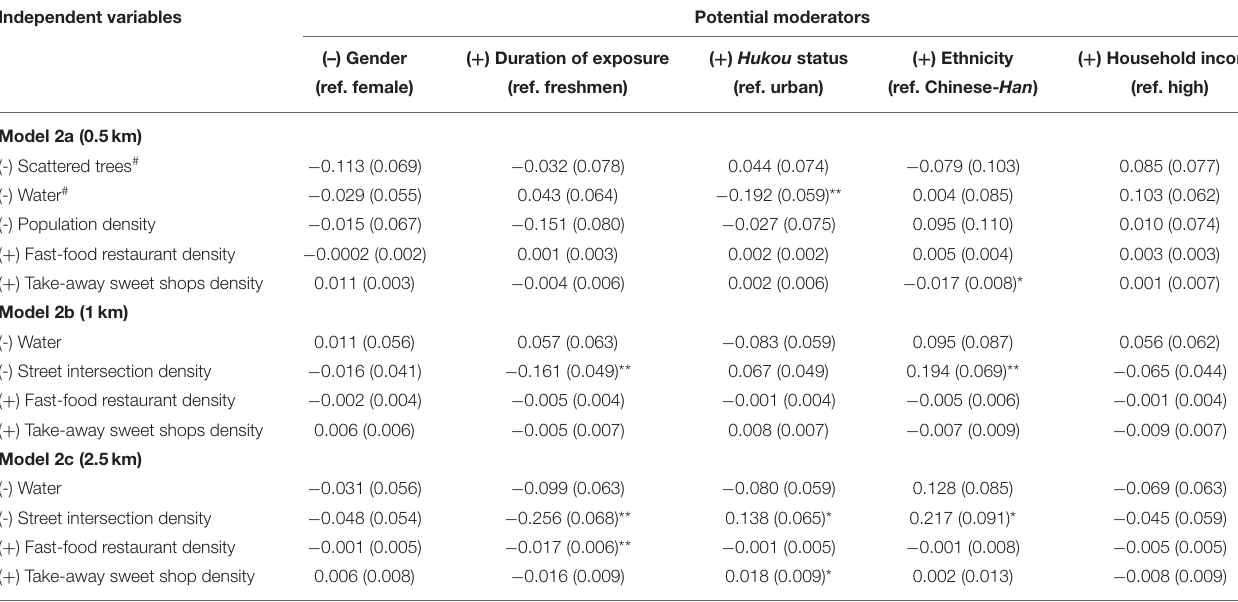
TABLE 4 | Results of multivariate linear associations between depression in undergraduates and exposure to natural-built environments at multiple scales and with interaction effects of socioeconomic attributes. Independent